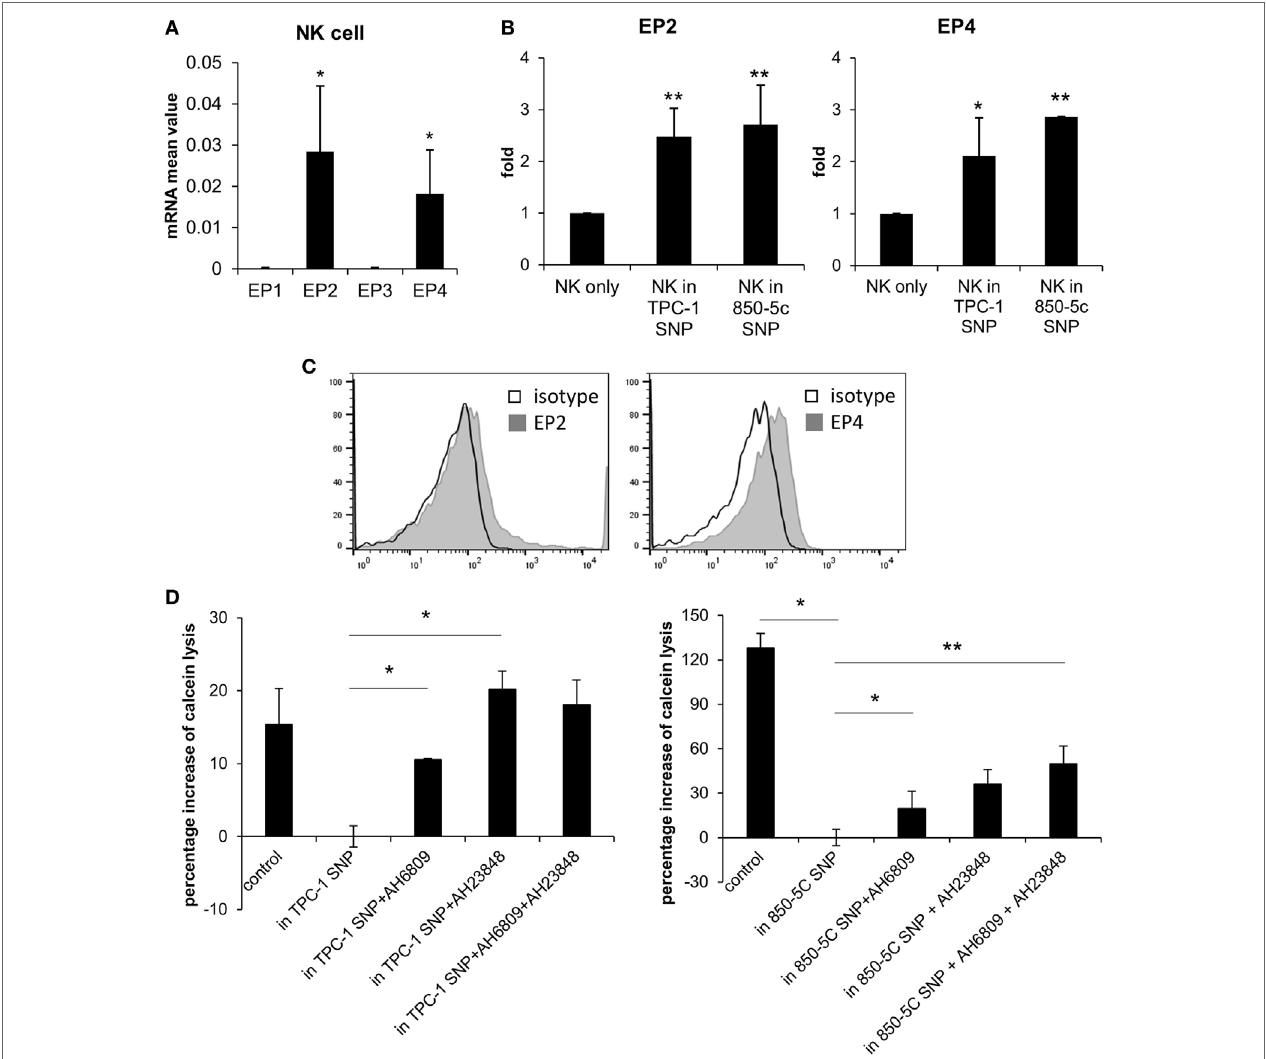
FigUre 3 | PGE2 inhibits natural killer (NK) cell activity via EP2 and EP4 receptors. (a) mRNA level of EP receptors on NK cells and (B) changes in EP2 and EP4 expression after culturing with thyroid cancer cell supernatants for 48 h, as determined by real-time PCR. Glyceraldehyde 3-phosphate dehydrogenase served as an internal control. (c) Histograms representing EP2 and EP4 expression in NK cells detected by flow cytometry. (D) NK cells were cultured with IL-2 for 48 h in control medium or in culture supernatant without or with AH6809 (EP2 receptor antagonist) or AH23848 (EP4 receptor antagonist). Cytotoxicity was assessed against K562 cells using calcein-AM. Effector to target ratio was 5:1. The graph was represented by calculating the percentage increase based on NK cells treated with cancer cell supernatant. Bars represent mean ± SD of three independent experiments. * P < 0.05 and ** P < 0.01 vs. NK cells cultured in thyroid cancer cell supernatants Statistical analysis was performed using the paired two-tailed Student’s t